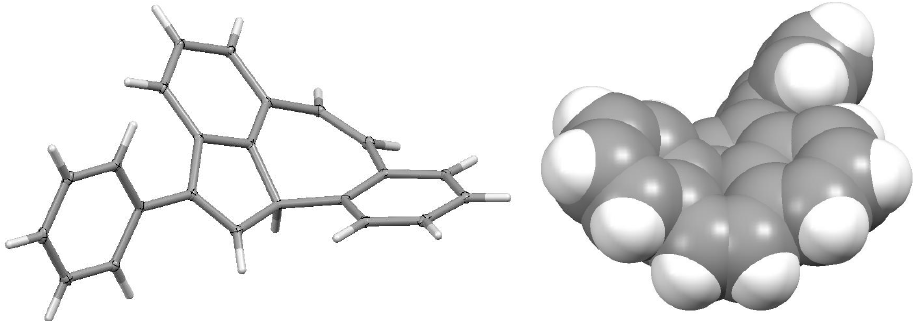
Figure 12. Molecular structure of 2-phenyl-11b H -dibenz[ cd , h ]azulene, 92.